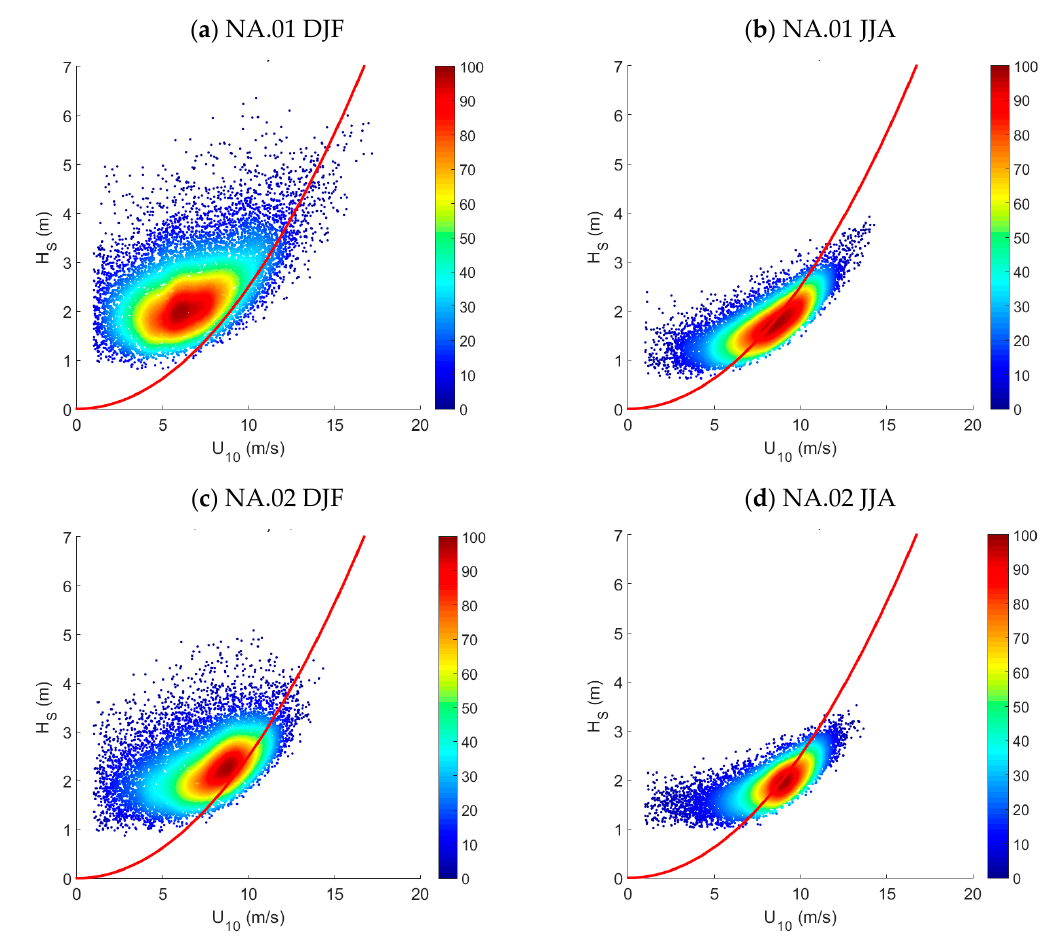
Figure 12. Same as Figure 10 but for key position and NA.01 (at 30° N–12° W) for ( a ) DJF and ( b ) JJA, and for position NA.02 (at 22° N–18° W) for ( c ) DJF and ( d ) JJA.